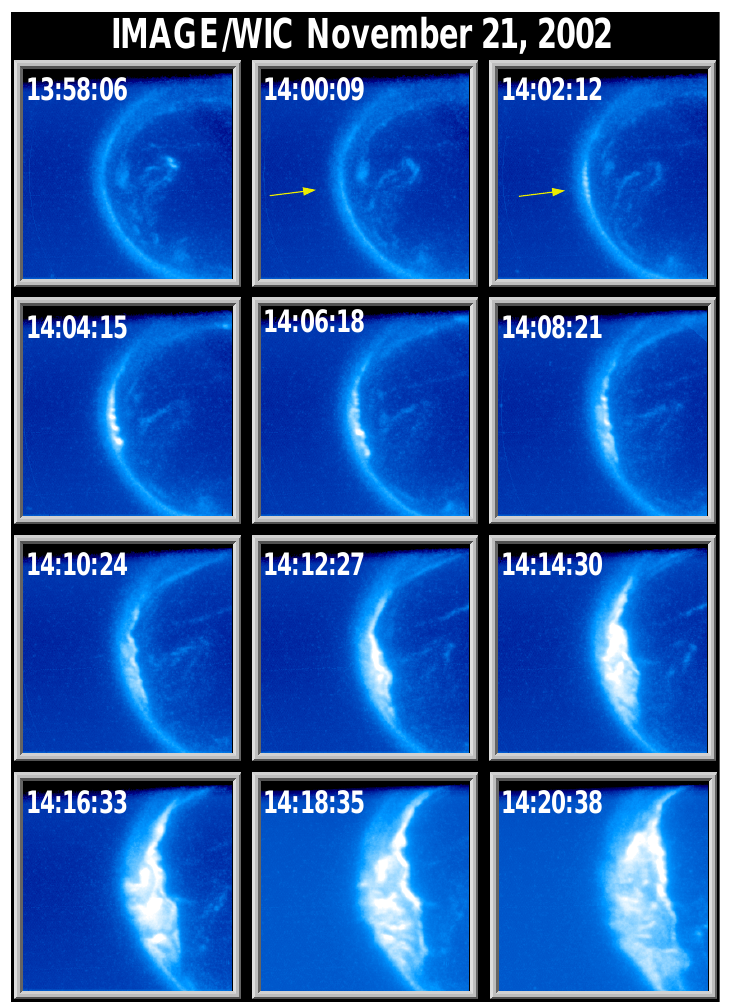
Fig. 1. Sequence of IMAGE FUV/WIC images showing the evolution of the northern auroral distribution during a substorm which occurred on 21 November